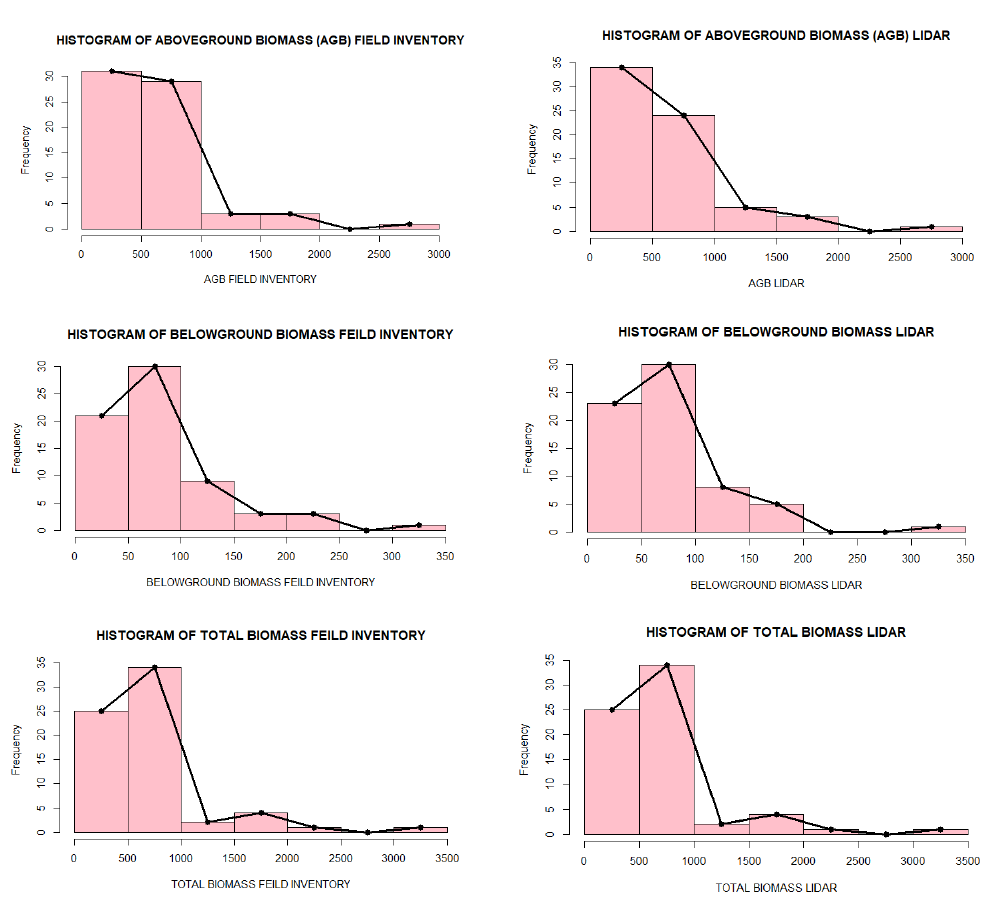
Figure 9. Histograms distribution of aboveground, belowground, and total biomass (kg) calculated with two types of inputs (forest parameters from field data collection and those extracted from UAV-ALS and TLS data (Lidar)) .